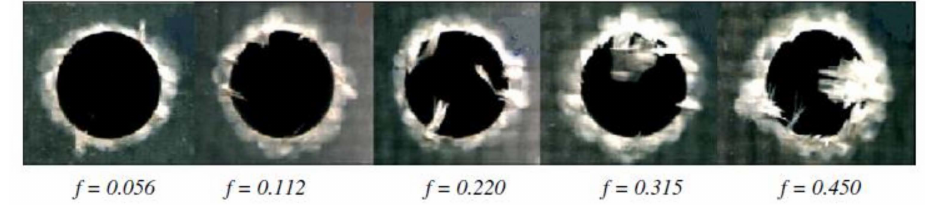
Figure 8. The e ff ect of push-out delamination in GFRP composite drilled by 13-mm diameter drill for di ff erent feed rates f [mm / rev] and the spindle speed of 20.253 m / min